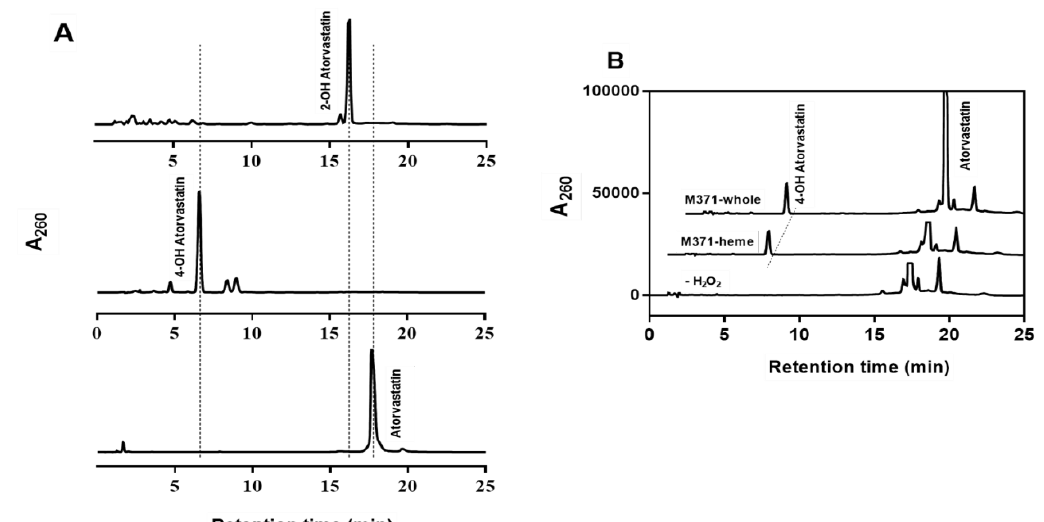
Figure 3. ( A ) HPLC chromatograms of substrate atorvastatin and its metabolites, 2-OH and 4-OH products. The concen- tration of each compound was 200 µ M. ( B ) HPLC chromatograms of atorvastatin metabolites produced by whole M371 and M371-heme domain in the presence of H 2 O 2 . The hydroxylation of 200 µ M atorvastatin by 0.20 µ M CYP102A1 (M371 whole enzyme or heme domain) in 100 mM of a potassium phosphate buffer (pH 7.4) was supported by externally added hydrogen peroxide (10 mM) at 37 ◦ C for 10 min. The reaction mixtures’ peaks of HPLC chromatograms were identified by comparing their retention times to those of the following standards: authentic 4-OH atorvastatin (t R = 6.8 min), 2-OH atorvastatin (t R = 16.2 min), and atorvastatin (t R = 17.3 min).